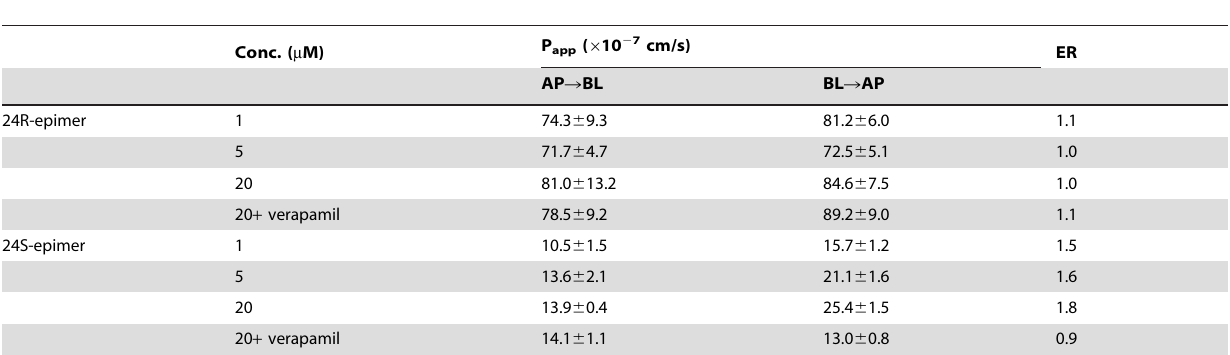
Table 3. The apparent permeability (P app ) and efflux ratio (ER) of 24R-epimer and 24S-epimer across Caco-2 monolayers.